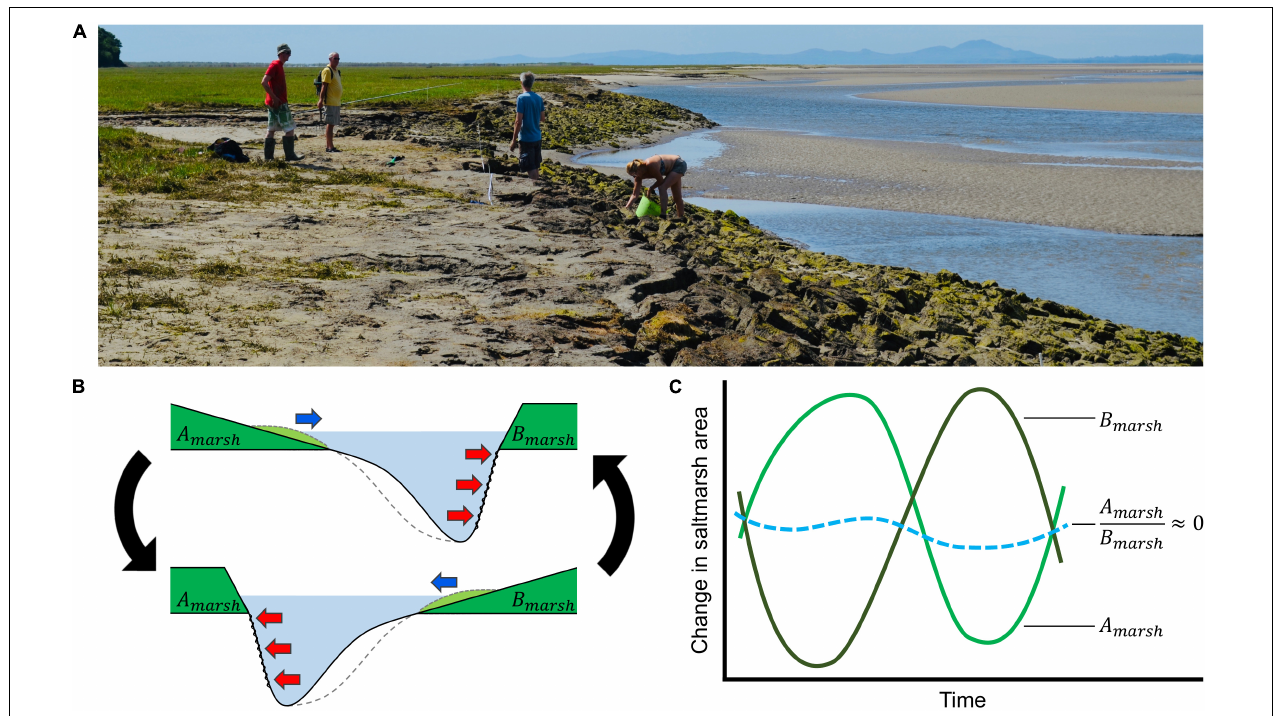
FIGURE 1 | (A) Salt marsh exposure to hydrological forcing strongly depends on the position of ever shifting tidal channels in estuaries. For a typical estuary, (B) marshes (green) are found on opposite banks, separated by tidal channels (light blue). (i) Erosion by scouring occurs as channels move nearer the marsh edge (red arrows). On the opposite bank, the migration of channels away from the marsh edge facilitates sediment deposition, allowing marshes to expand laterally (blue arrow). (ii) When the direction of channel migration eventually changes, marsh erosion and expansion patterns are reversed. We hypothesise that cyclical switching in the direction that channels migrate (black arrows) means that (C) marsh erosion and expansion is synchronised, resulting in no net change in marsh area (blue dashed line). Such a biogeomorphic system would represent a compensatory resilience mechanism on a landscape scale (image: Glaslyn-Dwyryd estuary,